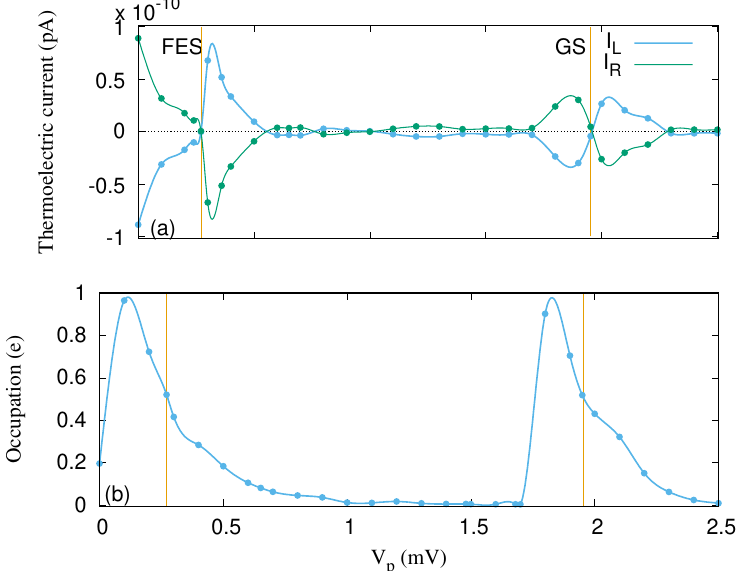
Figure 3. Thermoelectric current from the left lead to the QD system ( I L ) and the thermoelectric current from the QD system to the right lead ( I R ) ( a ) and occupation ( b ) versus the gate voltage V p for the QD system without the photon cavity. The temperature of the left (right) lead is fixed at T L = 1.16 K (T R = 0.58 K), implying thermal energy of 0.1 meV (0.05 meV). The chemical potential of the leads are fixed at µ L = µ R = 1.2 meV. The golden vertical lines indicate the resonance condition for the ground-state (GS) at V p = 1.95 mV and the first-excited state (FES) at V p = 0.271 mV. The magnetic field is B = 0.1 T, and ¯ h Ω 0 = 2.0